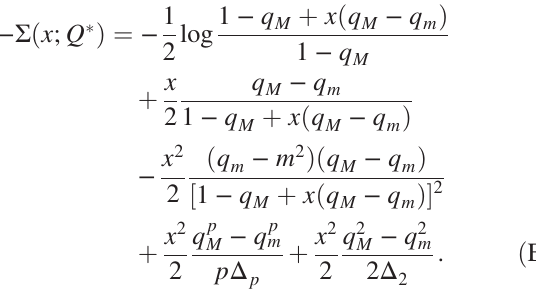
0 . 5 . The solid line characterizes the stable part p ¼